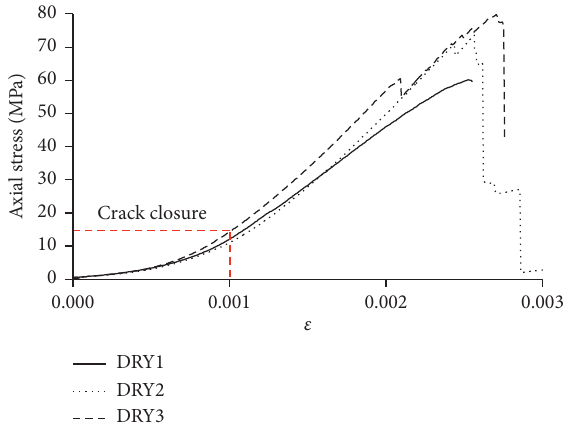
Figure 5: Tuff stress-strain curves under dry condition obtained from uniaxial compression test.